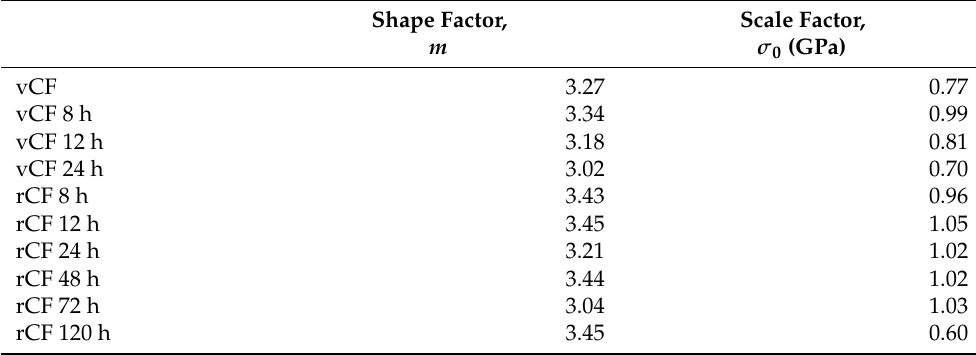
Table A1. Shape factor in the Weibull function and scale factors taken for vCF and rCF.